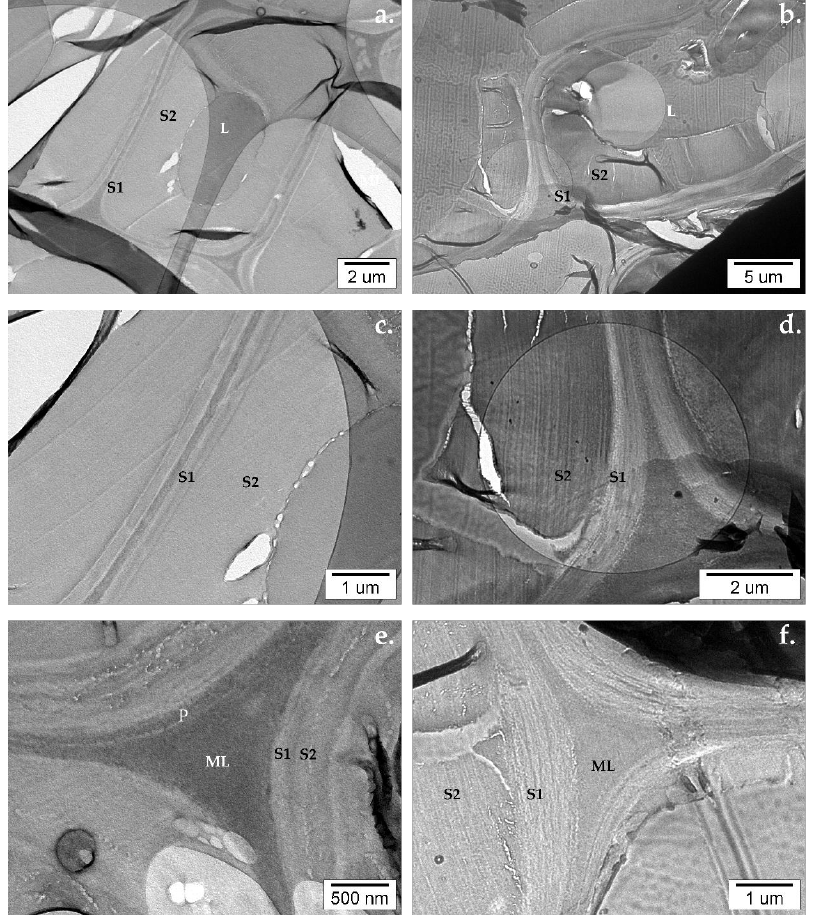
Figure 16. TEM micrographs of uncoated sample irradiated with UV light: ( a , c , e ) beech and ( b , d , f ) pine wood’s cell wall ultrastructure. The presence of TiO 2 in the samples of coated wood was confirmed with EELS. Frag- ile, several-micron-large planar TiO 2 particles, when mixed with water to create a coating, broke into smaller planar particles of hundreds of nanometers or minute individual par- ticles of 25 – 30 nm as seen in Figure 17. In only a few places, the TiO 2 coating stayed on the wood’s surface ( Figure 17a). In some cases, clusters of TiO 2 particles were found in the lumen (Figure 17b) or in the wood ’ s structure (Figure 17d). Fissures and holes appeared in the vicinity of TiO 2 clusters (Figure 17d).